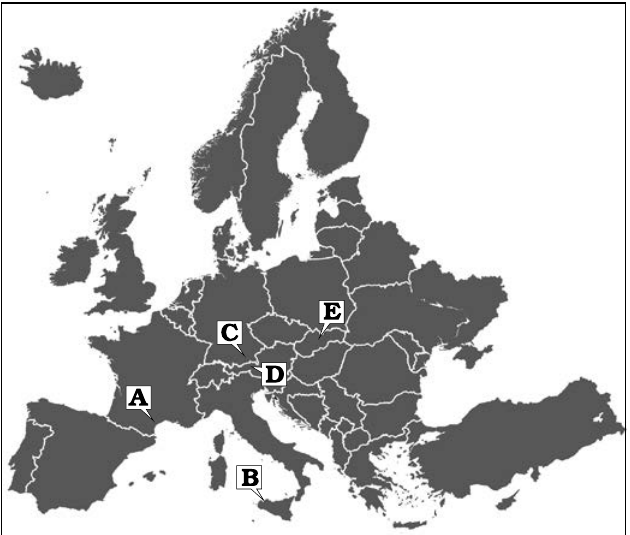
Fig. 1. Map with type localities of the species discussed in the text indi- cated. A . Chinia nella ellembergeri (Lebouché and Lemoine in Granier and Deloffre, 1994) Granier, Masse and Berthou, 1994, emend. nov., upper Sine murian (Jurassic) of Canders (Languedoc, France). B . Distefanopolia micropora (Di Stefano and Senowbari-Daryan, 1985) and Distefanopolia macropora (Di Stefano, 1981 ex Di Stefano and Senowbari-Daryan, 1985) nov. comb., Norian (Upper Triassic), Cozzo di Lupo (Sicily, Italy). C . Diste- fano polia zanklii (Ott, 1967) nov. comb., Norian–Rhaetian (Upper Triassic) of Dürreck berg (Upper Bavaria, Germany). D . Distefanopolia crosii (Ott, 1968) nov. comb., Upper Triassic of Kohlalpen Valley (Kaiser Mountains, Austria). E . Distefanopolia carpatica (Bystrický, 1967) nov. comb., Norian (Upper Triassic) of Muráň Plateau (Slovakia).